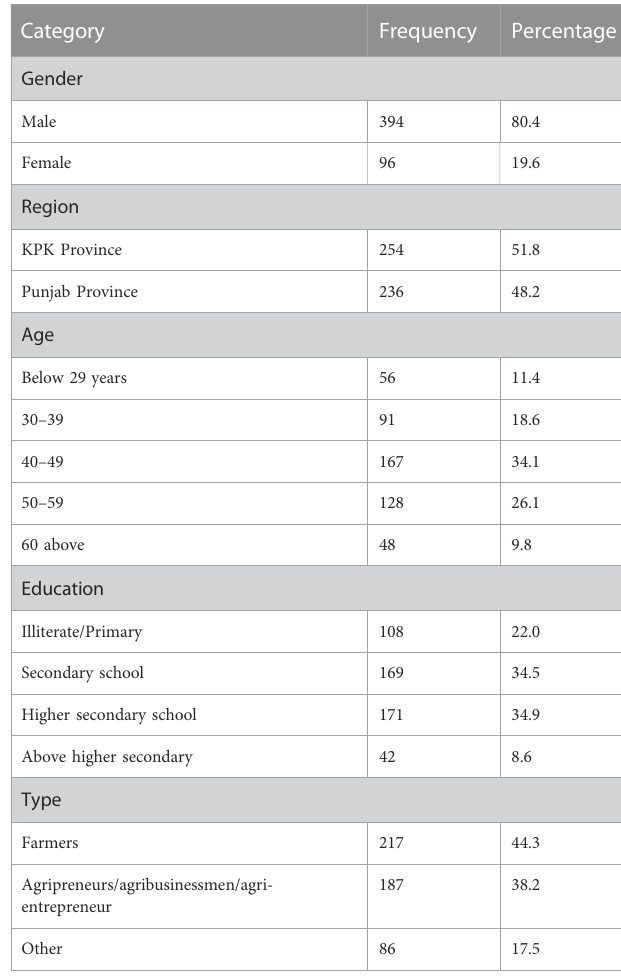
TABLE 1 Demographic fi gures for